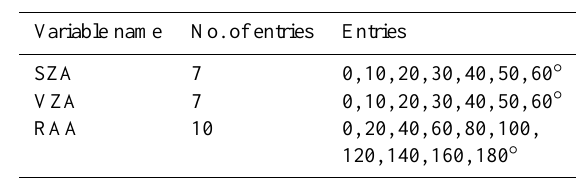
Table 2. Dimensions of LUT for the clear-sky comparison.